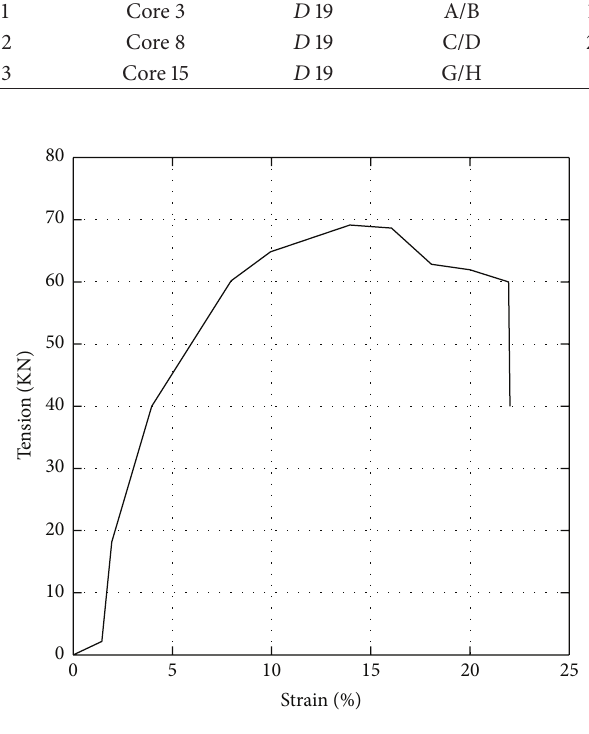
Figure 16: Force and displacement of rebar from tension test.